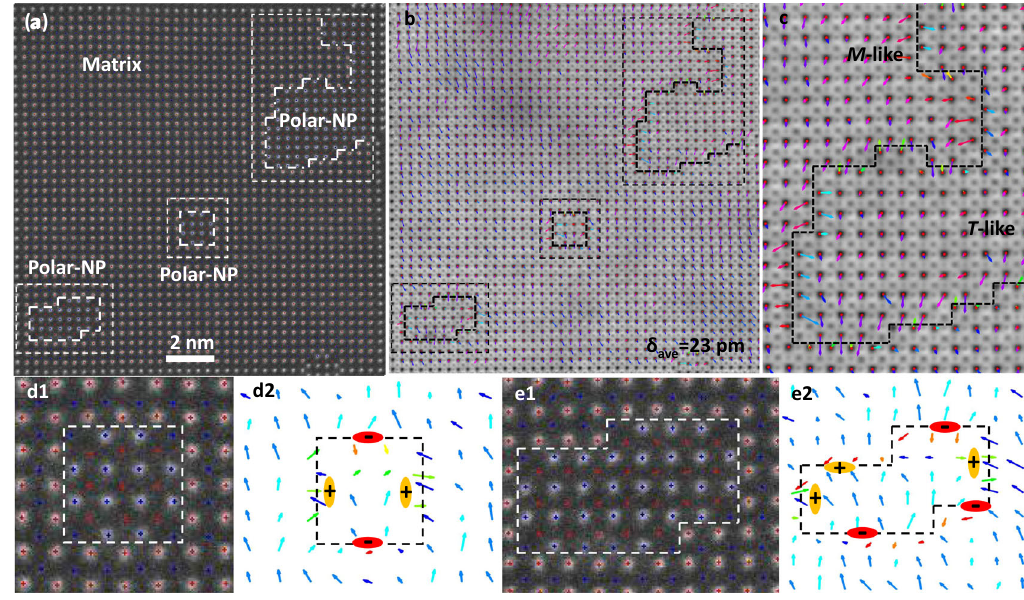
Fig. 3 Charge and polarization analysis. a Plan-view STEM HAADF image of NP-NNO fi lm, where three nanopillars are marked. b Colorized polarization ( δ Nb - O ) arrow map overlaid on the respective STEM ABF image of a , where the corresponding nanopillars are marked. c Enlarged image of the region with a large nanopillar marked in b . d1 , e1 Enlarged images of the regular nanopillar with 12 Nb atoms and polar nanopillar. d2 , e2 Colorized polarization arrow map of d1 , e1 ,